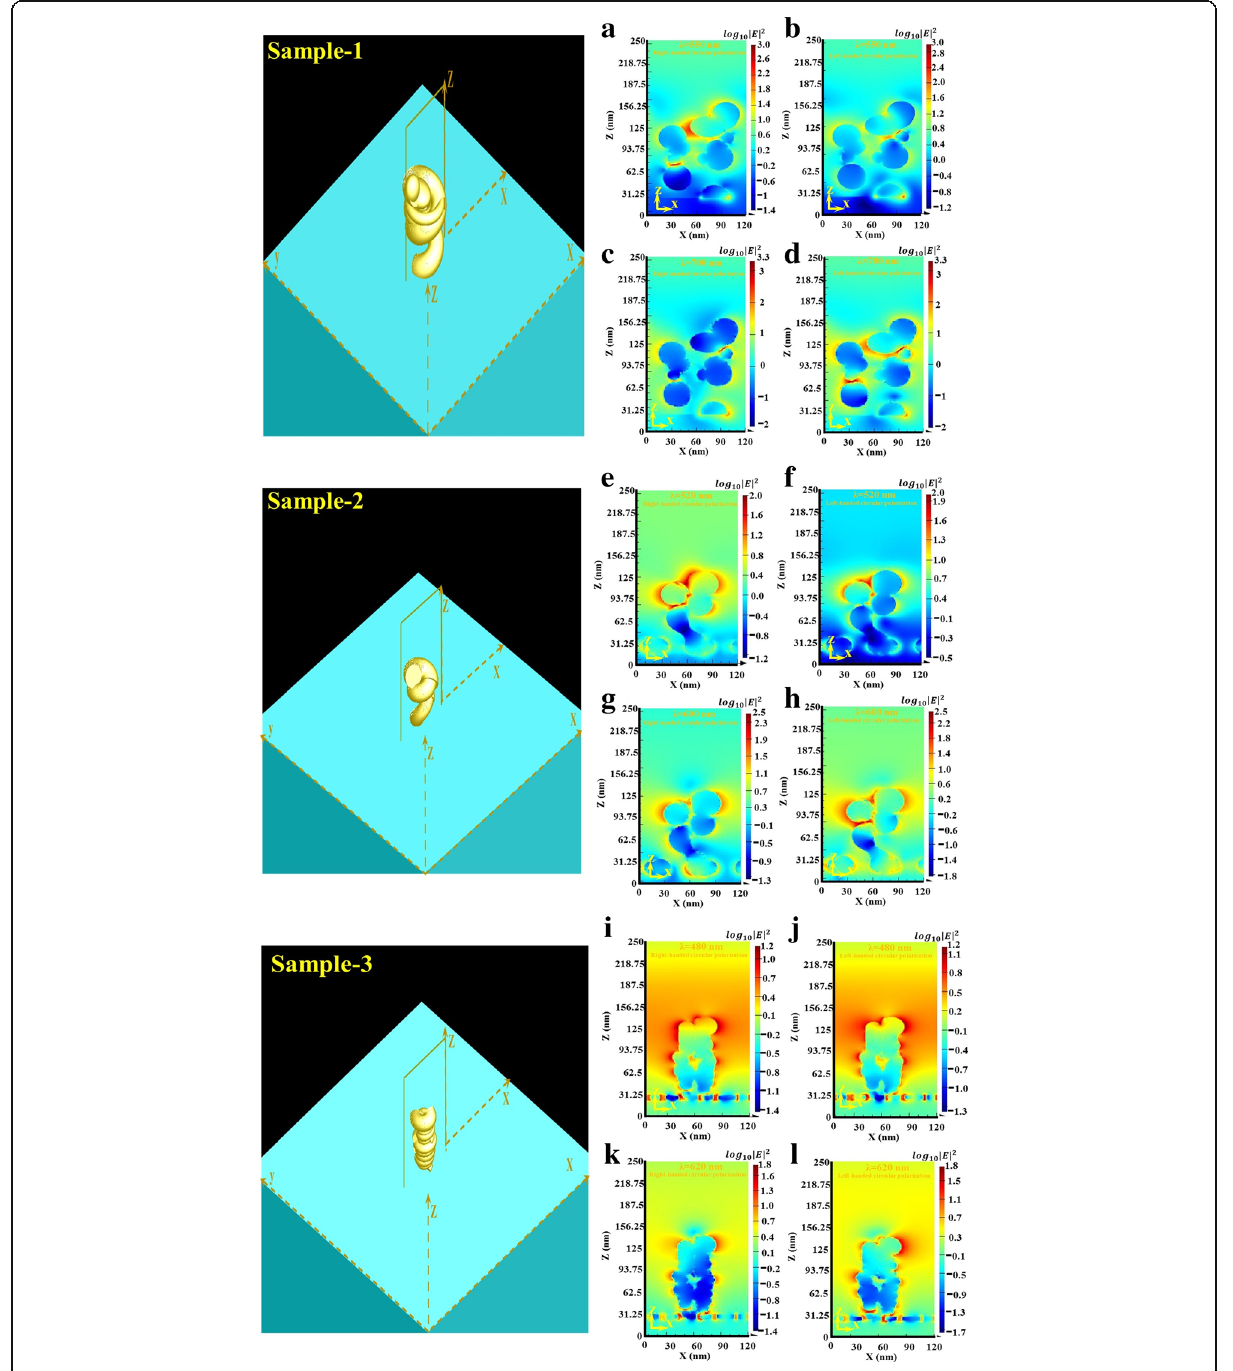
Fig. 8 Schematic diagrams of Au nanohelices and electric field intensity distribution of sample 1 ( a – d ), sample 2 ( e – h ), and sample 3 ( i – l